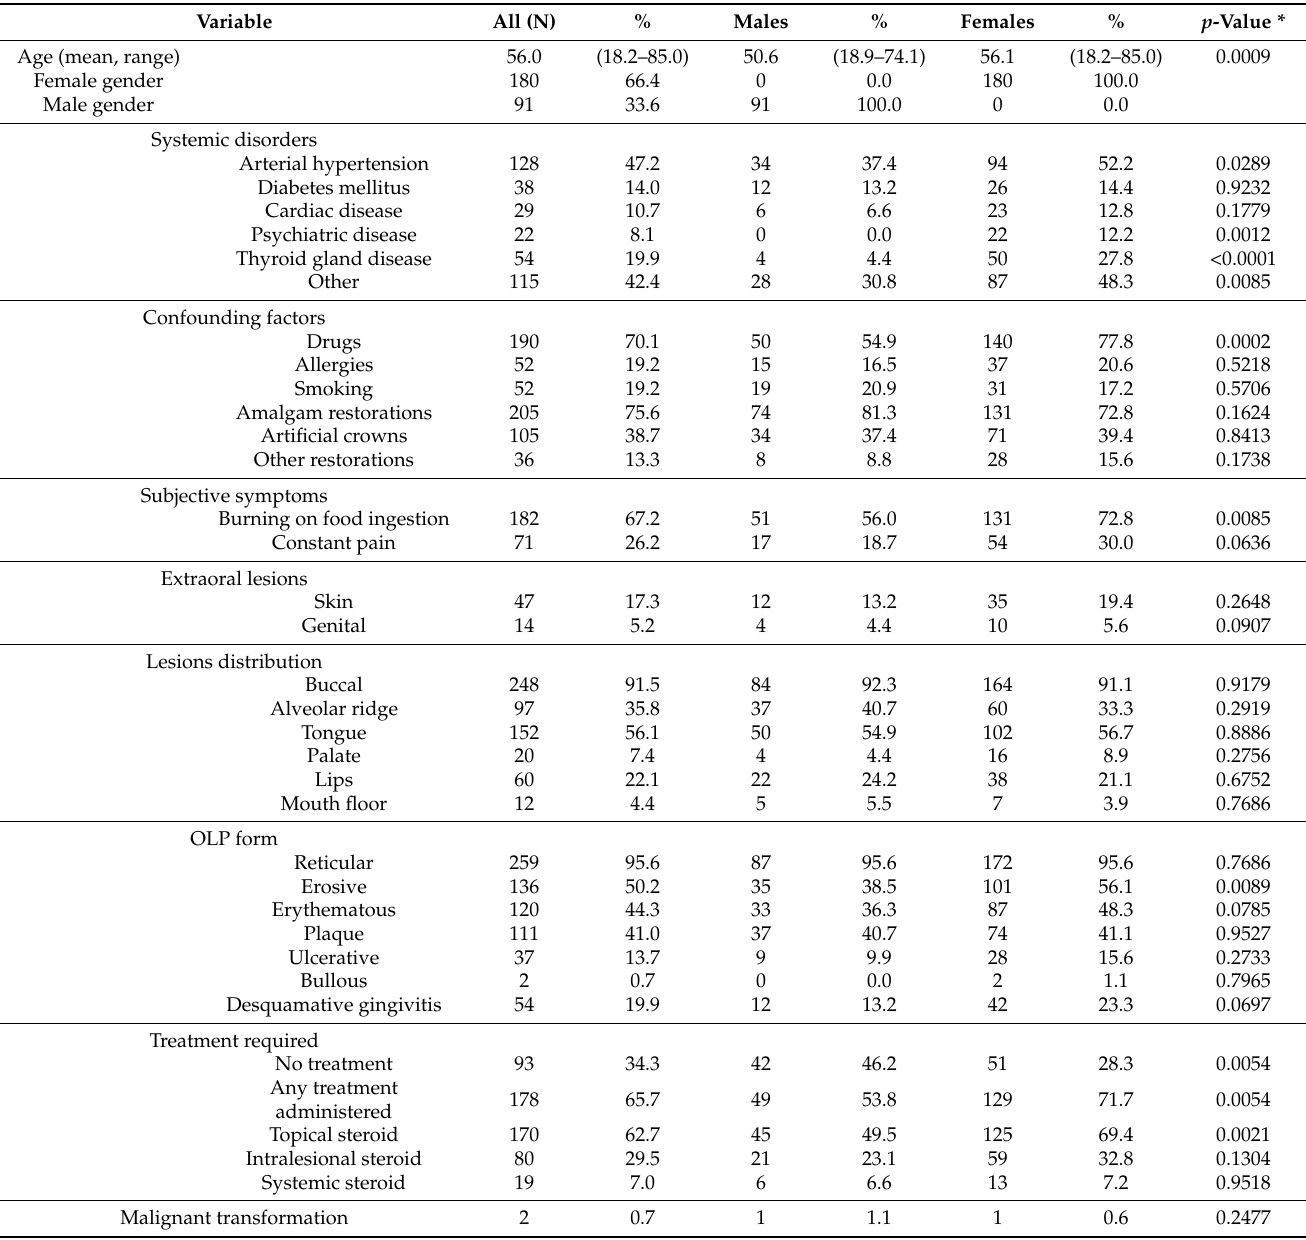
Table 1. Basic characteristic of all